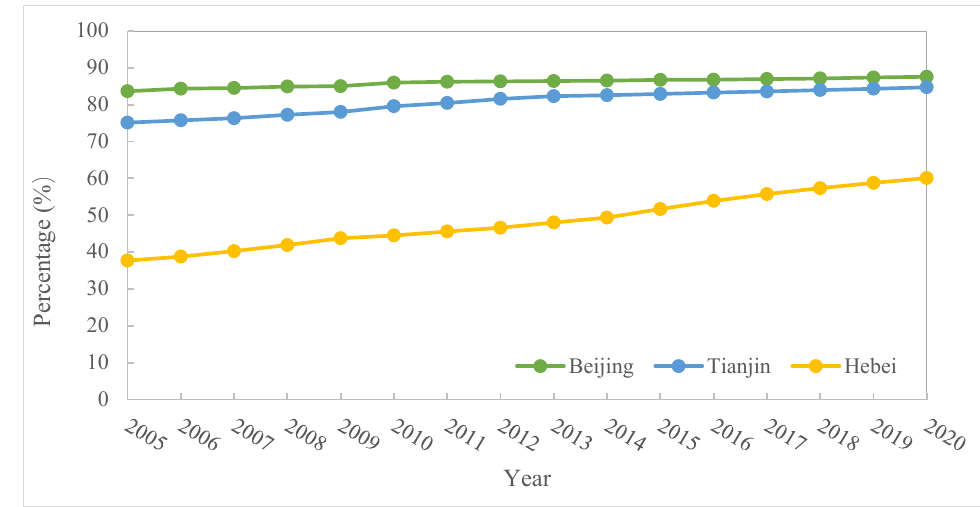
Figure 2. Urban population percentage in Beijing, Tianjin, and Hebei from 2005 to 2020. Note: The data are available from the China Population Statistics Yearbook since 2005.